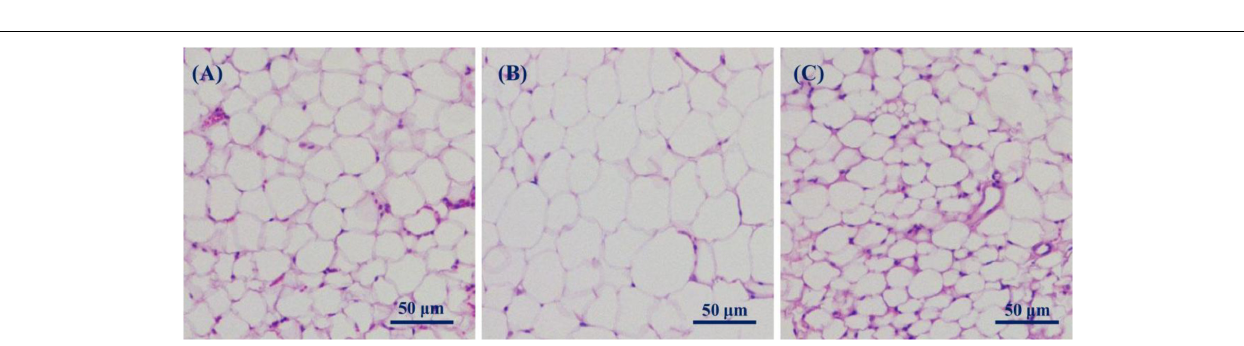
FIGURE 5 | Fat histology images (HE staining). (A) LFC; (B) HFD; and (C)